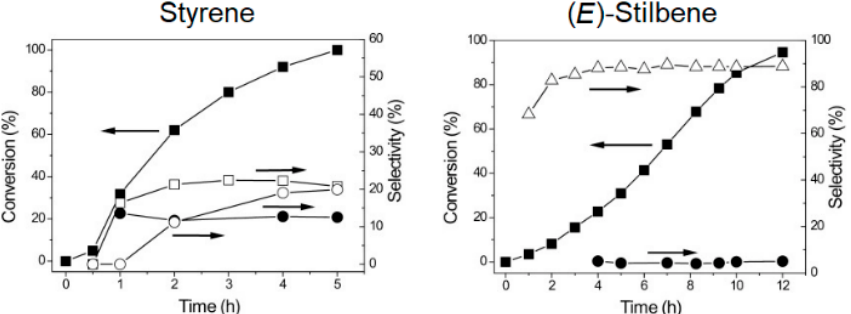
Figure 25. The epoxidation reaction of styrene ( left ) and ( E )-stilbene ( right ) with the Co-based metal–organic framework material STA-12(Co). The graph on the left shows styrene conversion ( ▪ ), as well as the selectivity for styrene oxide ( □ ), benzaldehyde (•), and benzoic acid ( ○ ). The graph on the right shows ( E )-stilbene conversion ( ▪ ), as well as the selectivity for trans -stilbene oxide ( Δ ) and benzaldehyde (•). Adapted with permission from reference. [114]. Copyright 2012, Wiley-VCH Verlag GmbH & Co.